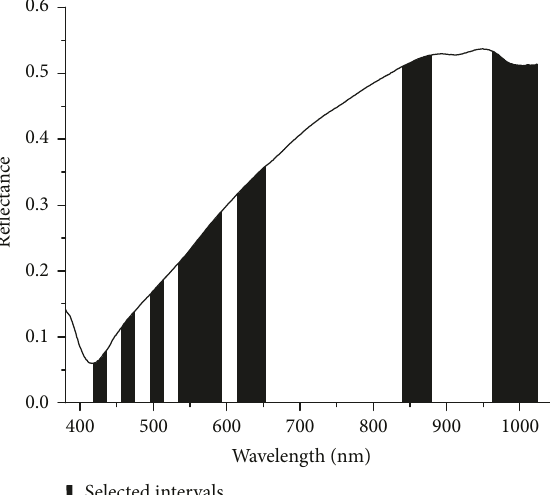
Figure 8: 13 intervals selected by BiPLS. Columns represent selected